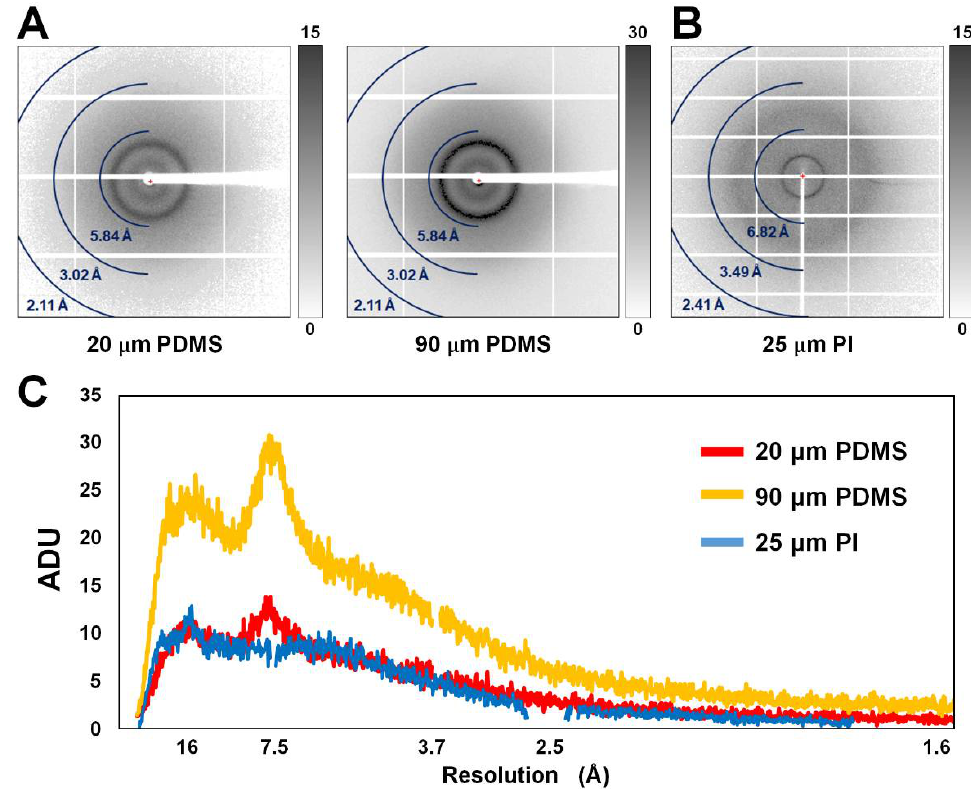
Figure 1. Analysis of synchrotron X-ray scattering of PDMS and PI. X-ray scattering images of ( A ) PDMS and ( B ) PI. ( C ) 2D profile of background scattering of PDMS and PI. ( A ) PDMS and ( B ) PI. ( C ) 2D profile of background scattering of PDMS and